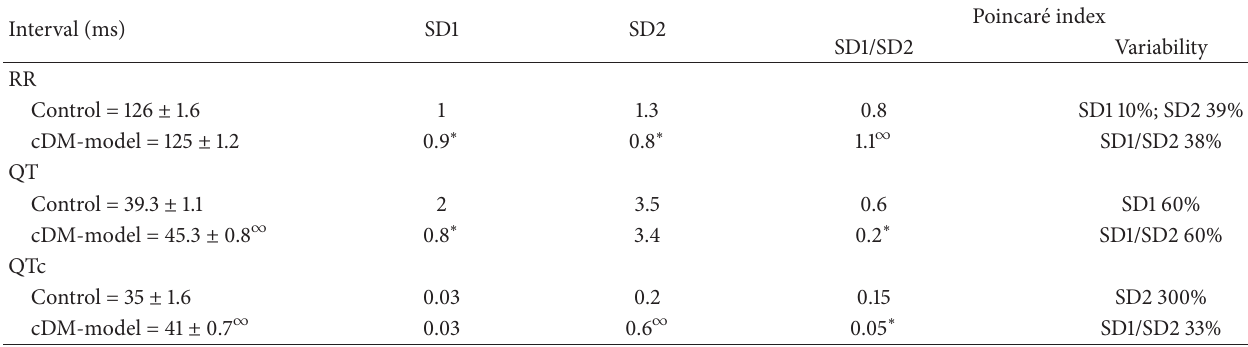
Table 2: Heart rate variability.